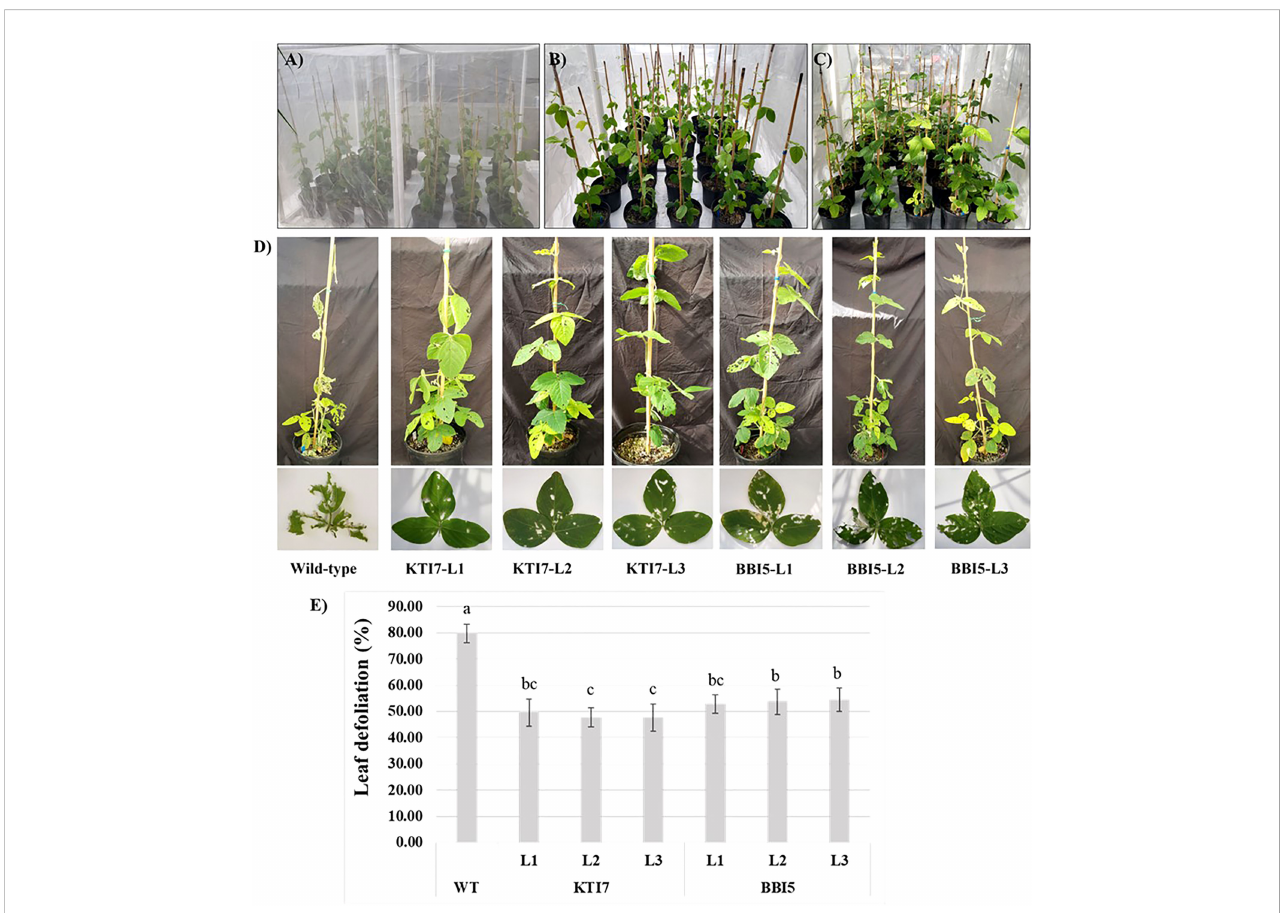
FIGURE 7 Whole plant feeding bioassay using six-week-old T 3 transgenic soybean plants that contain the rbcS-SRS4 promoter driving the expression of trypsin inhibitor genes (KTI7 and BBI5) grown under greenhouse conditions with corn earworm ( Helicoverpa zea ) second instar larvae. (A) Representative of transgenic and non-transgenic wild-type soybean plants in a polyester-mesh cage. (B) Ten larvae were added to each plant. (C) Ten days after larvae feeding. (D) Representative defoliated wild-type and transgenic plants. (E) Leaf defoliation rate after 10 days of larvae feeding of wild-type (WT) and transgenic lines. Bars represent mean values of six biological replicates (plants) per each independent line (L1, L2, L3) ± standard error. Bars with different letters are signi fi cantly different at p < 0.05 as tested by one-way analysis of variance followed by a Fisher ’ s least signi fi cant